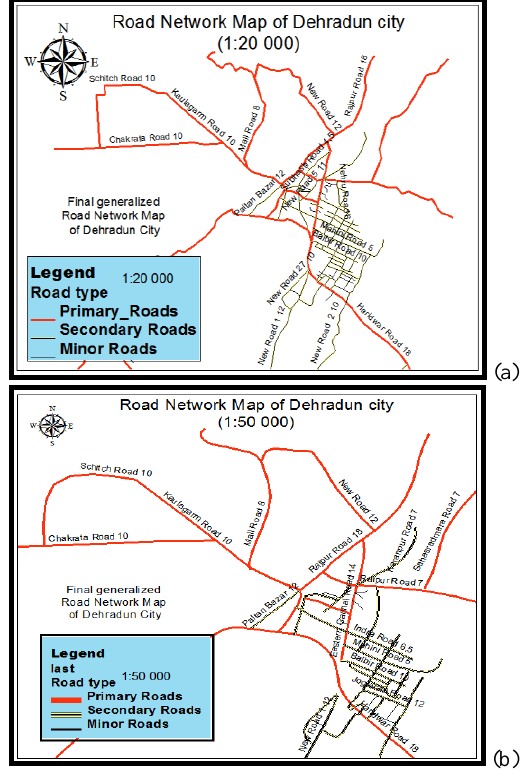
Figure 9: Comparison of the (a) Digitized road network at map scale 1:20 000 and (b) Generalized road network